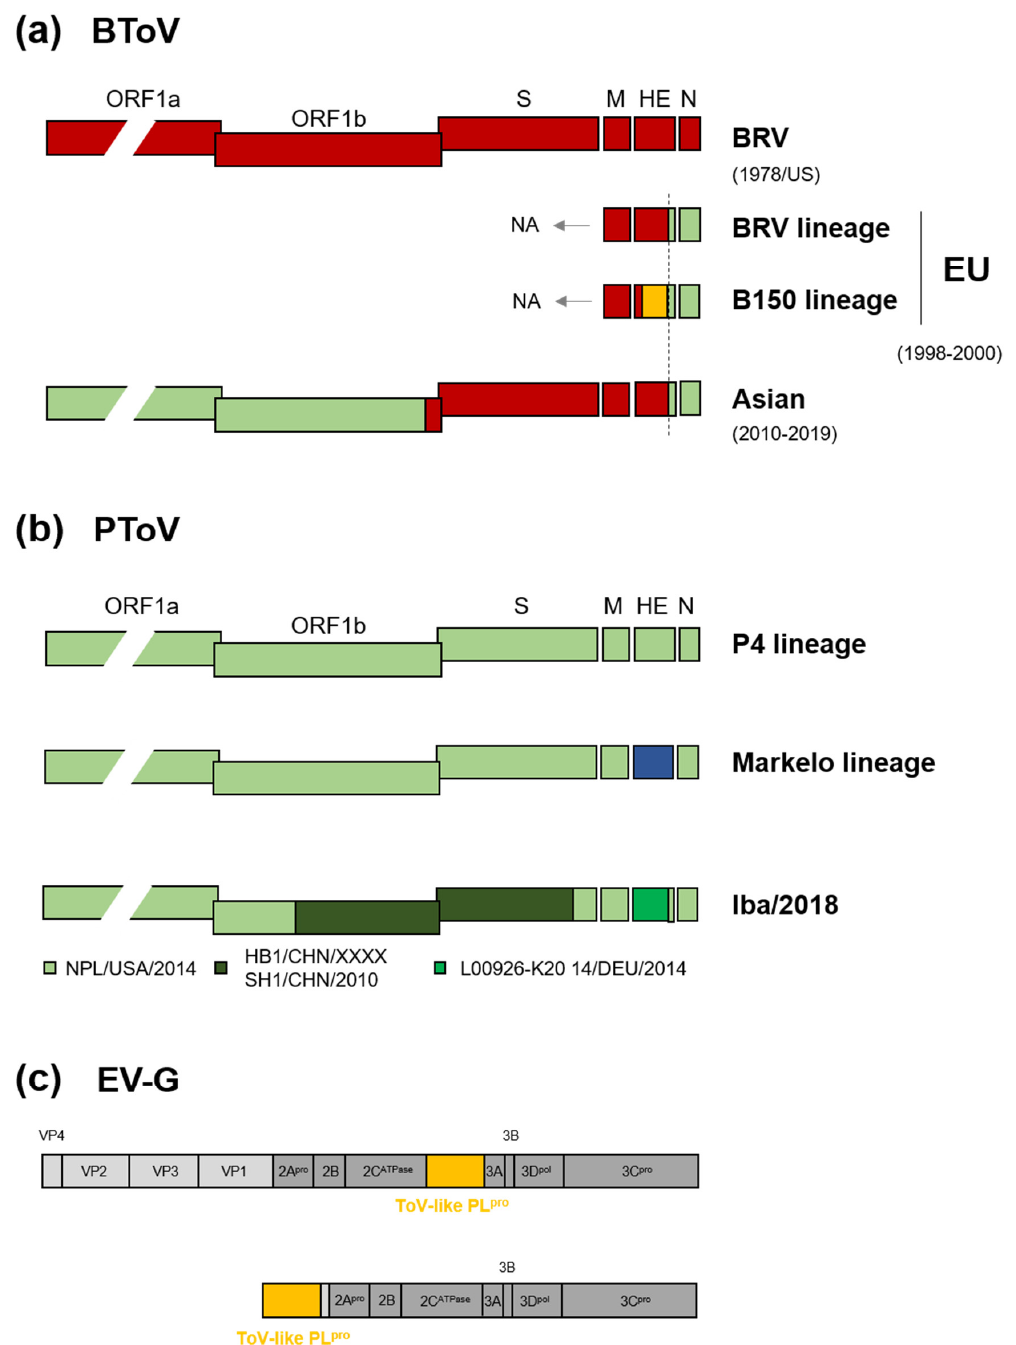
Figure 3. Homologous and heterologous recombination of ToVs. ( a ) Genome organisation of BToV by interspecies homologous recombination between BRV-like BToV (red) and PToV (green). Recombination of HE from an as-yet-unknown ToV is shown in orange. European and Asian isolates were from Italy, Hungary, the Netherlands, and Japan and China, respectively. Years of isolation are shown. BToV HE gene can be divided into two lineages, the BRV and B150 lineages. NA, not analysed. ( b ) Two lineages of PToV based on the HE gene and genome organisation of Japanese PToV (Iba/2018) with a mosaic sequence. The HE gene of the Markelo lineage is shown in blue. PToV (Iba/2018) may be a result of intraspecies homologous recombination among three related PToVs (named below). ( c ) Heterologous recombination between ToV and picornavirus. The ToV-like PL pro gene is inserted into the EV-G genome at the 2C/3A junction or is completely replaced by a viral structural gene up to the VP1/2A junction.